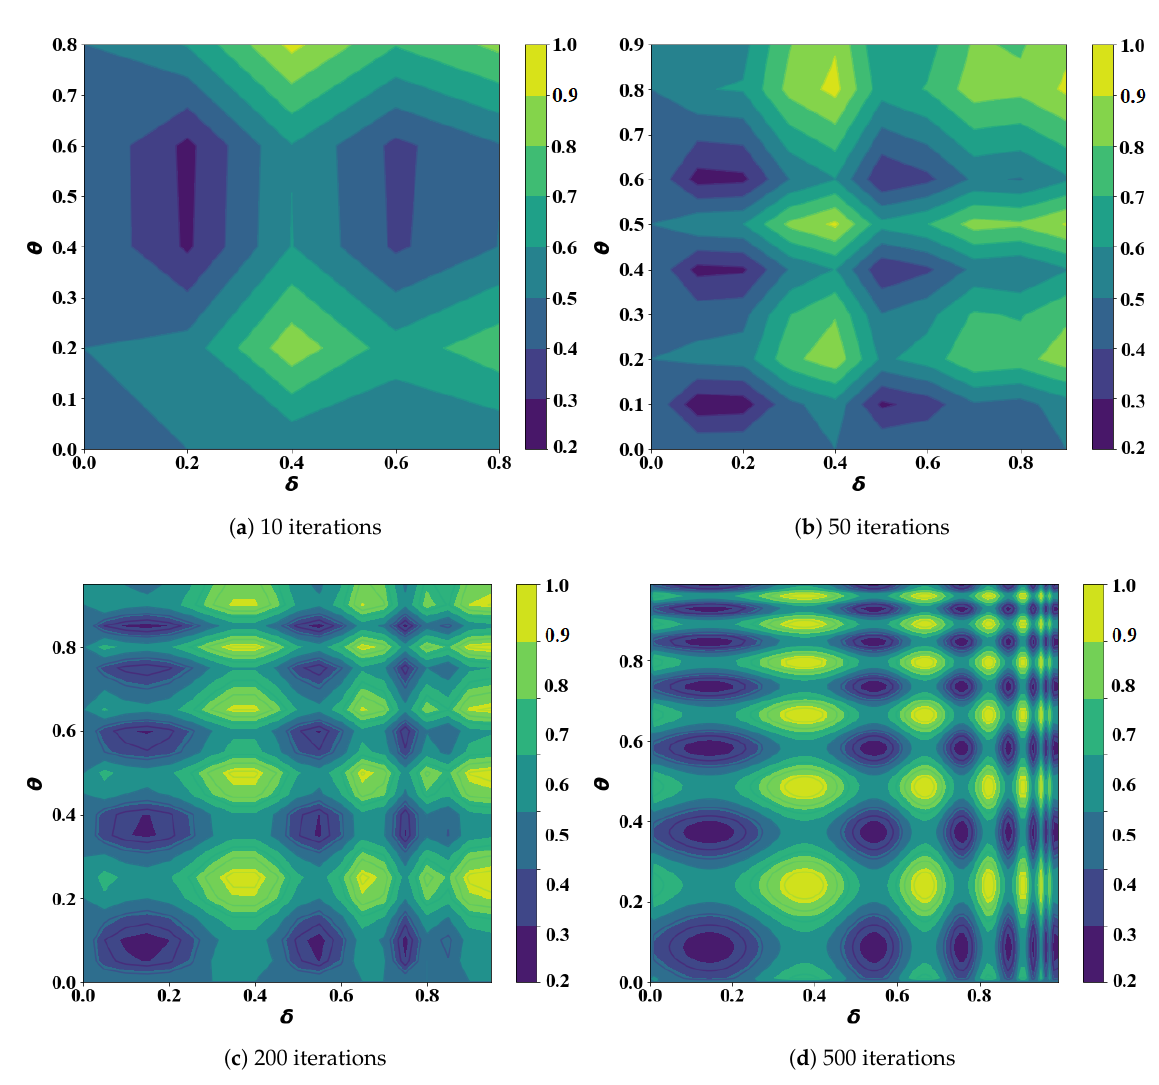
Figure 14. The contour plots in iterations.